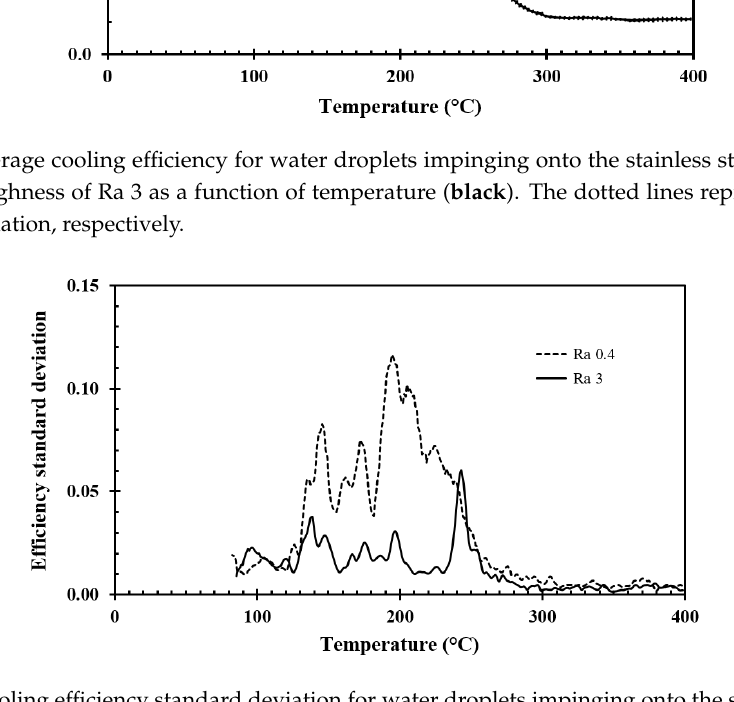
Figure 10. Cooling efficiency standard deviation for water droplets impinging onto the stainless steel disc with surface roughnesses of Ra 0.4 and Ra 3 (marked on the figure).